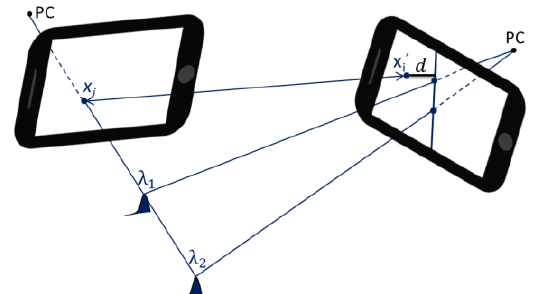
Figure 4. IOPs/ EOPs